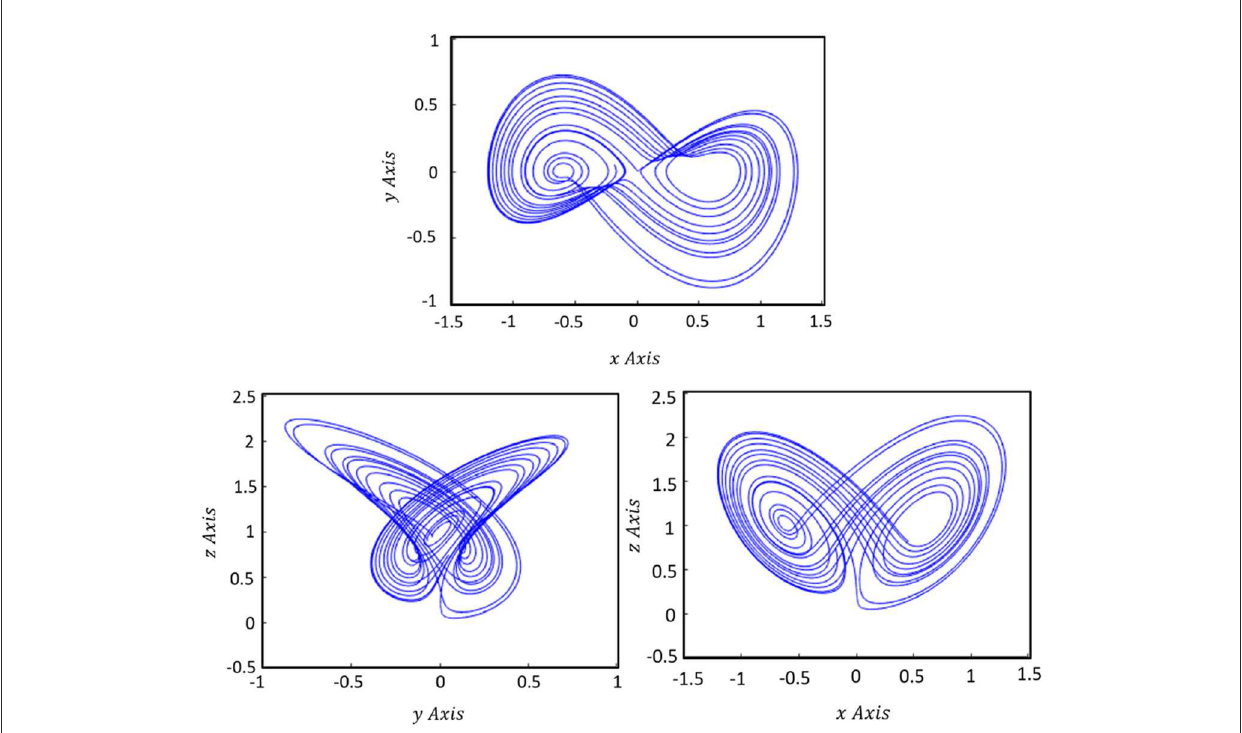
FIGURE1 The chaotic attractor of the Shimizu–Morioka dynamical system on the x Master